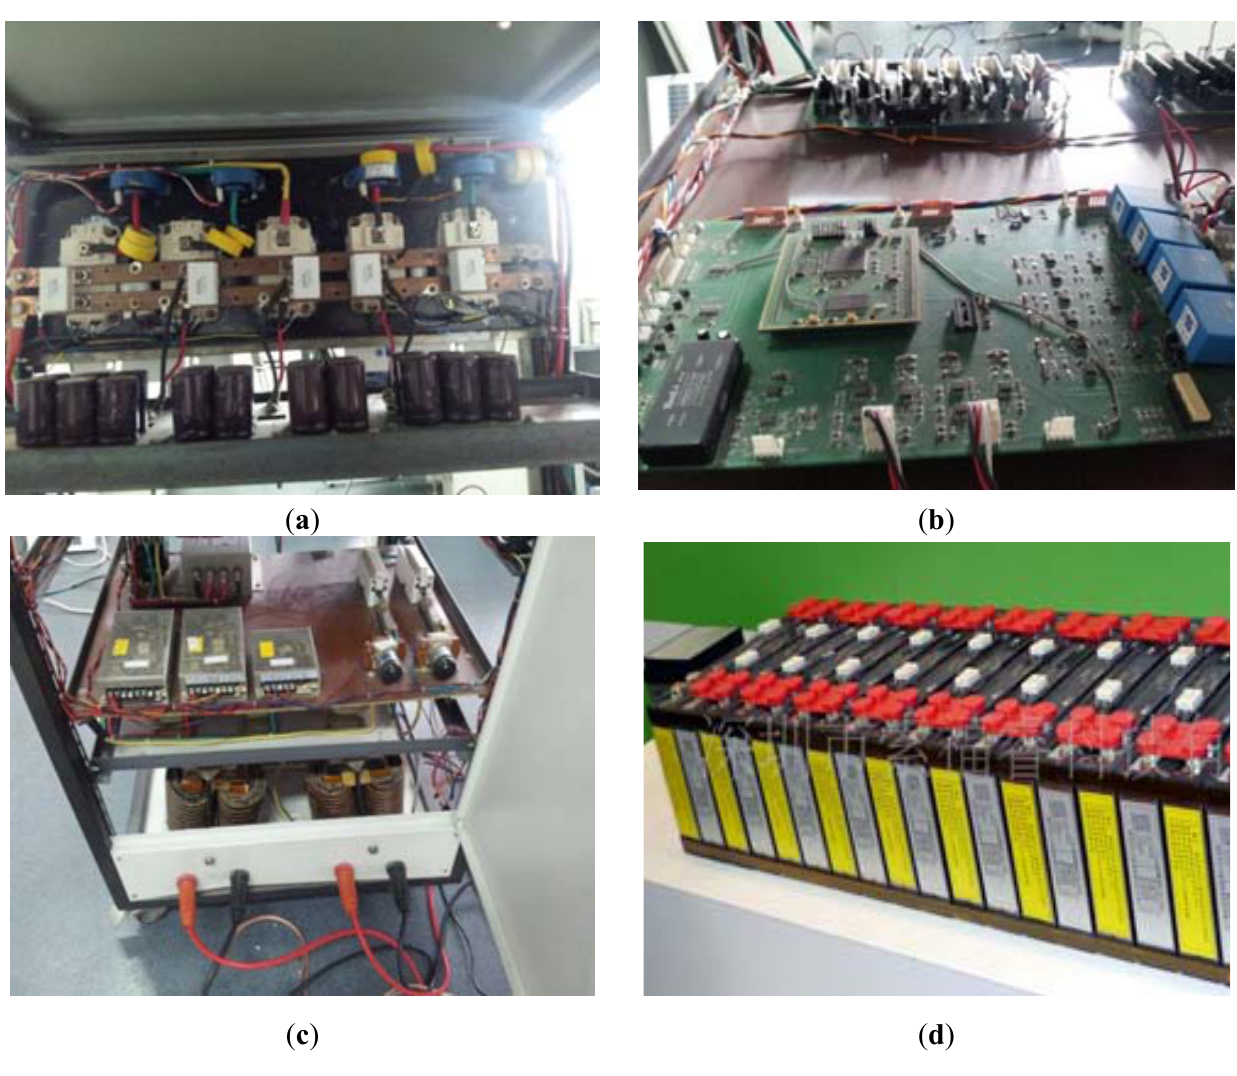
Figure 8. The three-phase NPC inverter based ERLPABTS for the experiment. ( a ) Power circuit of the system; ( b ) IGBT driving, protection and core control board; ( c ) Power input of the two-channel ERLPABTS; ( d ) Li-ion battery used for